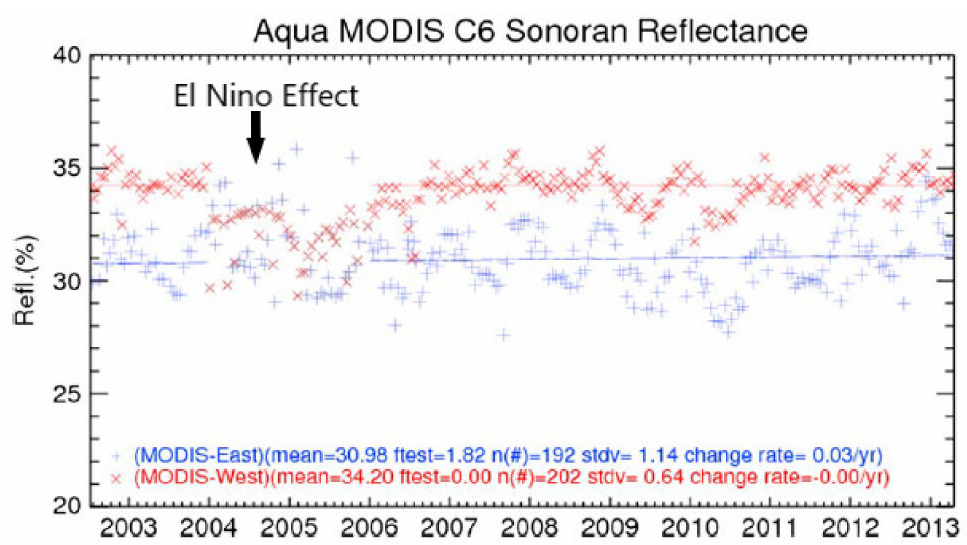
Figure 5. Observations of the Sonora Desert PICS by Aqua MODIS at locations equivalent to GOES-East (blue) and Goes-West (red). The data indicate that the Sonora Desert is a stable PICS but with uncertainties slightly larger than Saharan